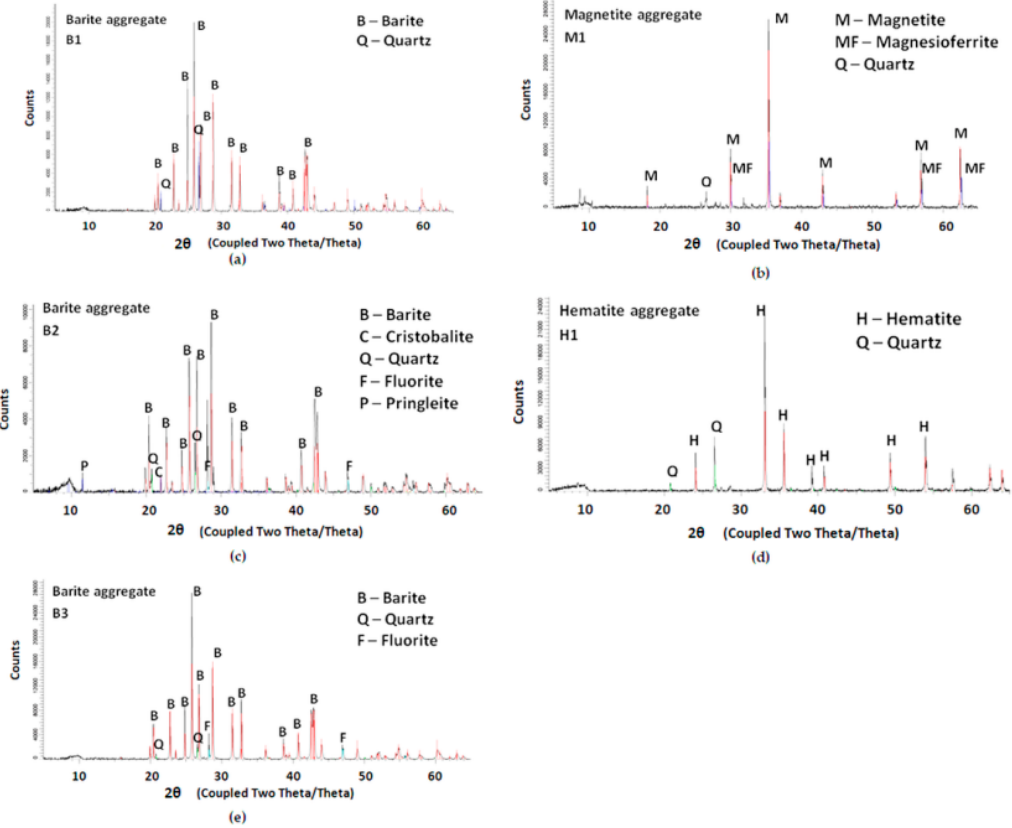
Figure 1. X-ray diffraction (XRD) patterns with main characteristic peaks in the tested high-density aggregates: ( a ) Barite B1, ( b ) Magnetite M1, ( c ) Barite B2, ( d ) Hematite H1, and ( e ) Barite B3.